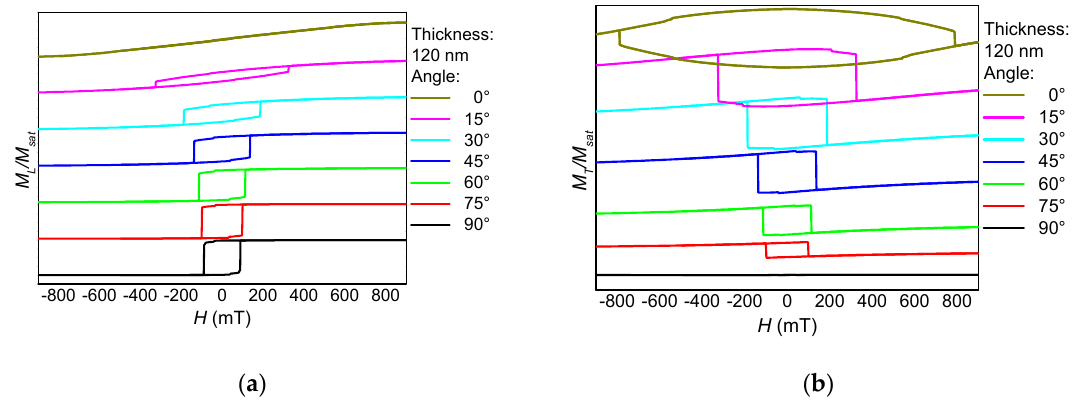
Figure 9. Angle dependence of ( a ) the longitudinal and ( b ) the transverse hysteresis loops, simulated for sample NF2 with a thickness of 120 nm.